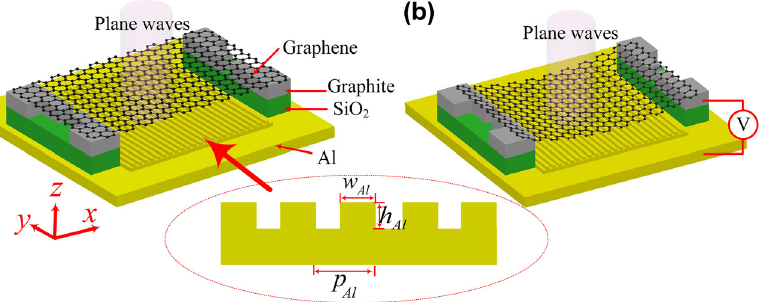
Figure 1: Schematic of UV modulation structure. (a) No voltage applied. (b) Schematic of graphene moving downward and shrinking after applying voltage. Electrodes are connected to a graphite and plasmonic metamaterial